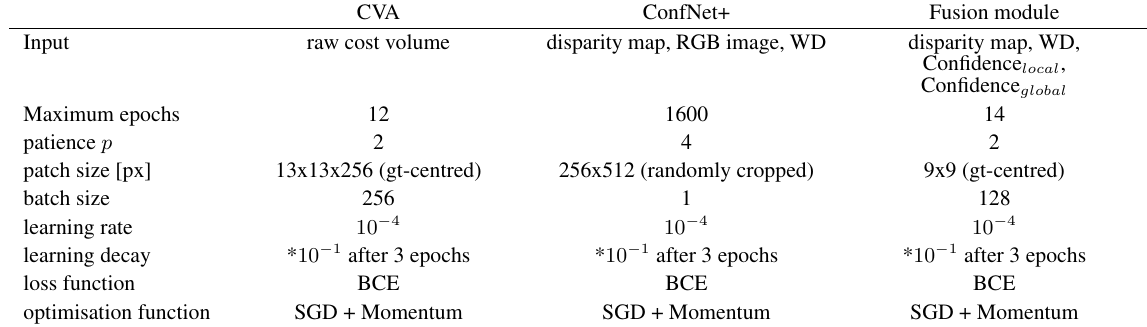
Table 1. Hyper-parameters of LGC+. Listed are the hyper-parameter relevant to train the modules of the proposed network LGC+, namely CVA, ConfNet+ and the late fusion module, with SGD referring to stochastic gradient descent and BCE to binary cross-entropy.